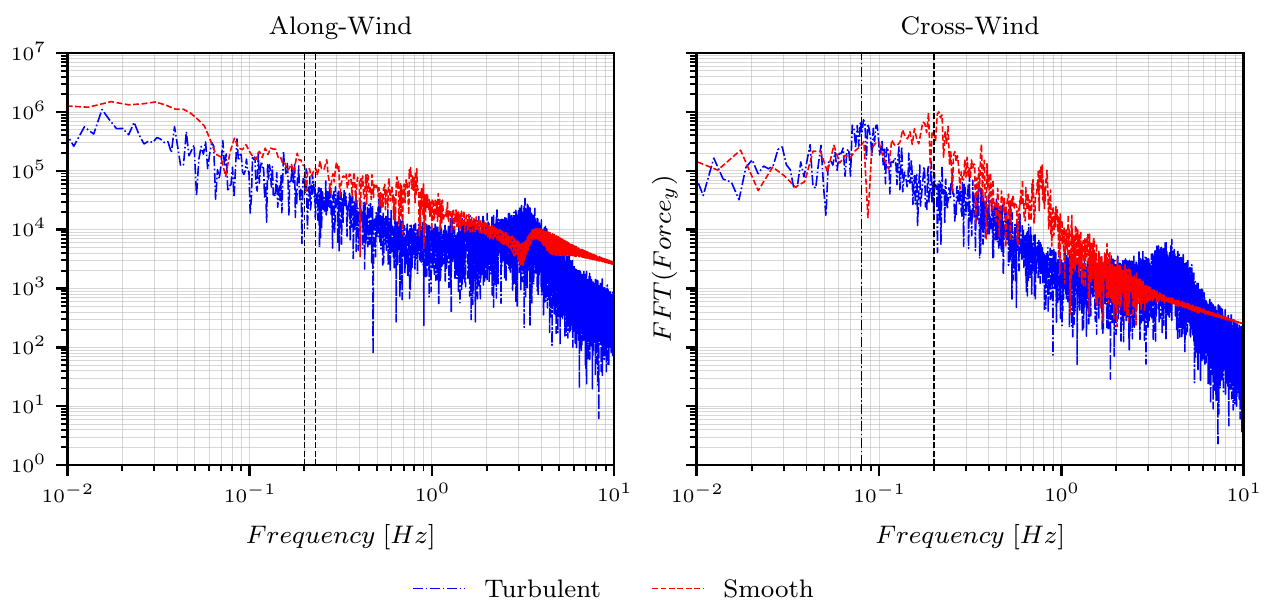
Figure 8. Spectral assessment of the energy content in the aerodynamic forces: turbulent flow for the 0 ◦ angle of attack, smooth in case of 90 ◦ angle of attack.